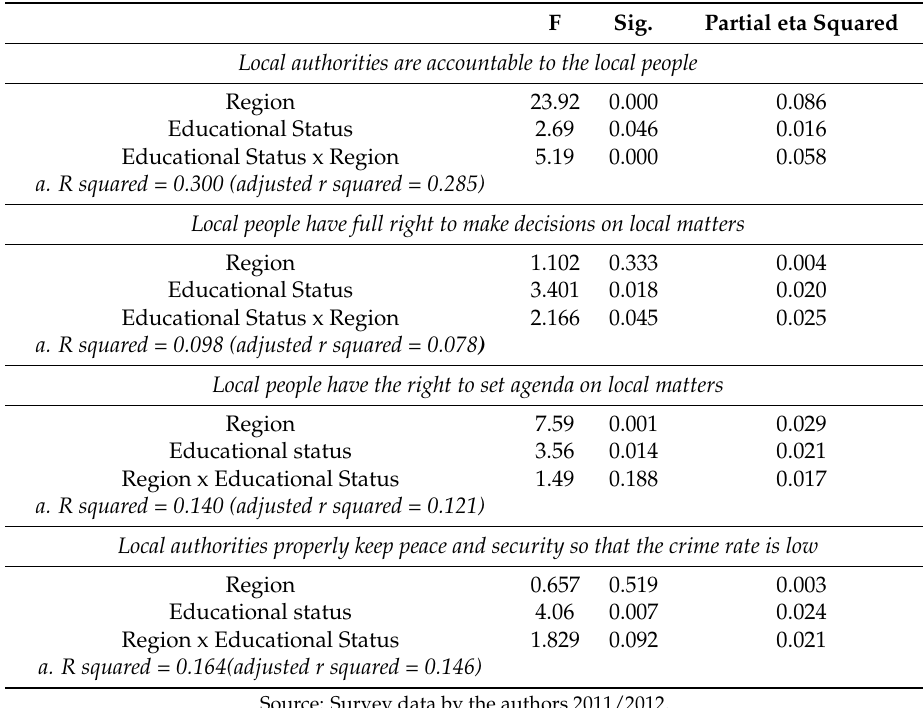
Figure 3. Regional difference in households’ views of power relations; source: survey data by the authors (2011/12). Table 5. Effects of education and regional variation on assessing aspects of power relations at local level (N =